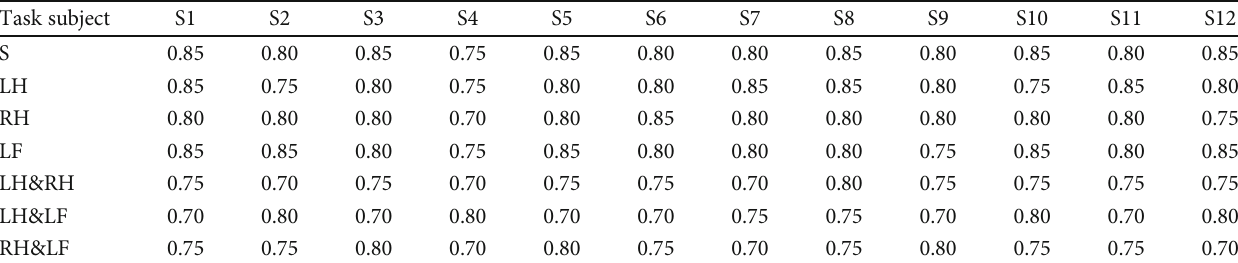
Table 1: The selection of thresholds for di ff erent motor imagination of di ff erent subjects.